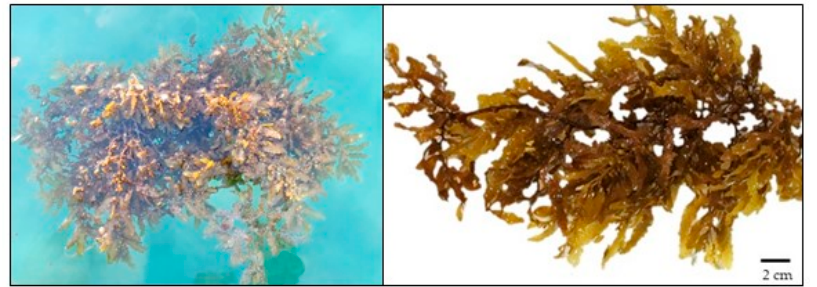
Figure 1. Fresh Sargassum polycystum collected from Kota Kinabalu, Sabah, Malaysia.